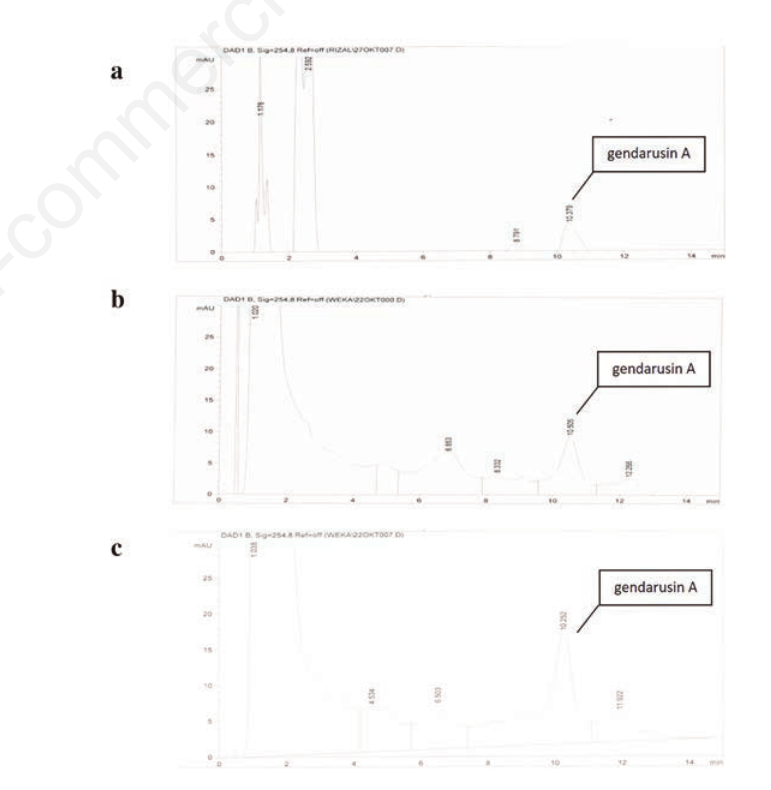
Figure 2. Chromatogram profile of gendarusin A in 12.8 µg/ml solution (a), gendarusin A in 5000.0 µg/ml of the 70%-fractionated ethanol extract of J. gendarussa leaves (b), gendarusin A in 5000.0 µg/ml of the 70% ethanol extract of J. gendarussa leaves